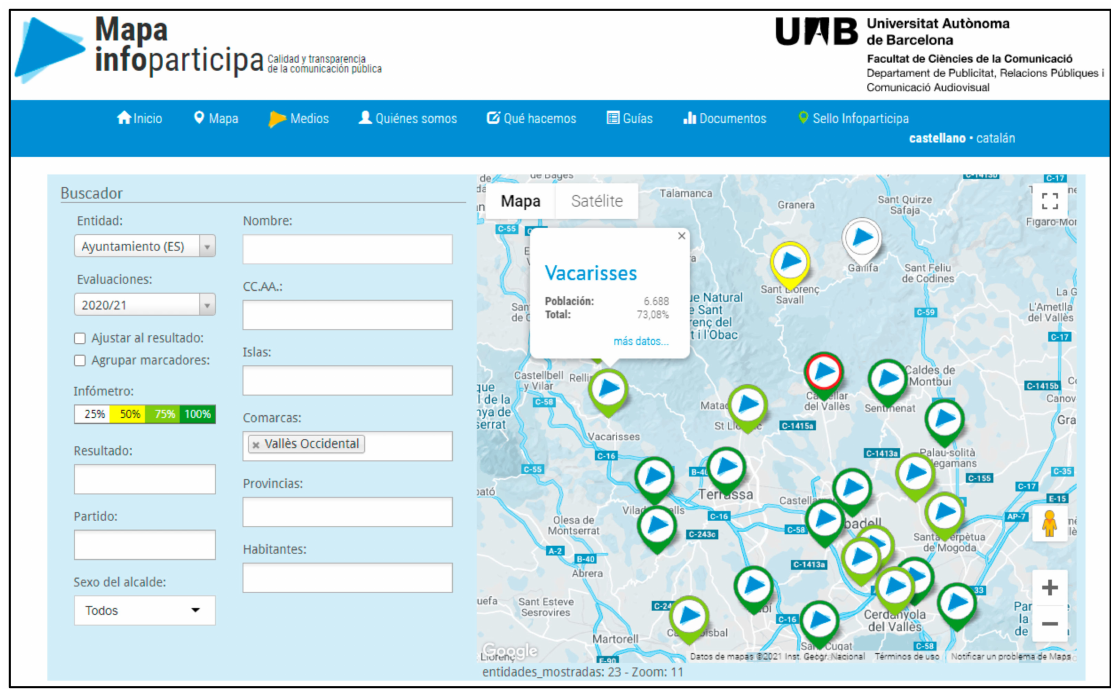
Figure 1. Screenshot of the Mapa Infoparticipa (13 May 2021), selection of the Town Councils of Spain, evaluation 2020/2021, Vall è s Occidental region. Window with information on the Town Council of